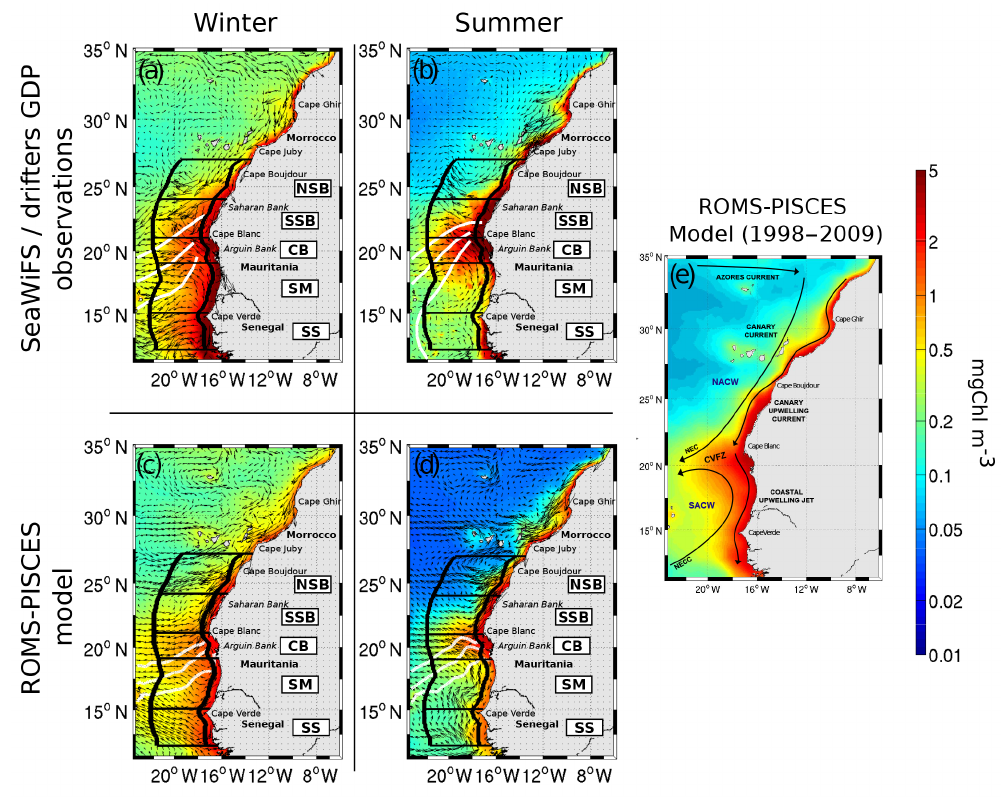
Figure 1. Seasonal climatology of sea surface chlorophyll concentrations (background) from SeaWiFS satellite data (1998–2009), near- surface currents (vectors) from the Global Drifter Program (GDP, 1979–present, Lumpkin and Johnson, 2013) and nitrate concentration at 100m depth (white contours of 10, 15 and 20mmol Nm − 3 from north to south) from the World Ocean Atlas 2013 (Garcia et al., 2014) in (a) winter (January–March) and (b) summer (July–September). Same seasonal climatology computed with the 5-day outputs of ROMS- PISCES in (c) winter and (d) summer. Main surface currents and deep water masses over the study area are presented over a map of simulated surface chlorophyll averaged over the SeaWIFS period (e) . NEC: North Equatorial Current; NECC: North Equatorial Counter current; CVFZ: Cape Verde Frontal Zone; NACW: North Atlantic Central Water; SACW: South Atlantic Central Water. The 5 coastal and 5 offshore boxes used in this study are superimposed (black boxes): northern Saharan Bank (NSB), southern Saharan Bank (SSB), Cape Blanc area (CB), Senegalo-Mauritanian region (SM) and southern Senegal region